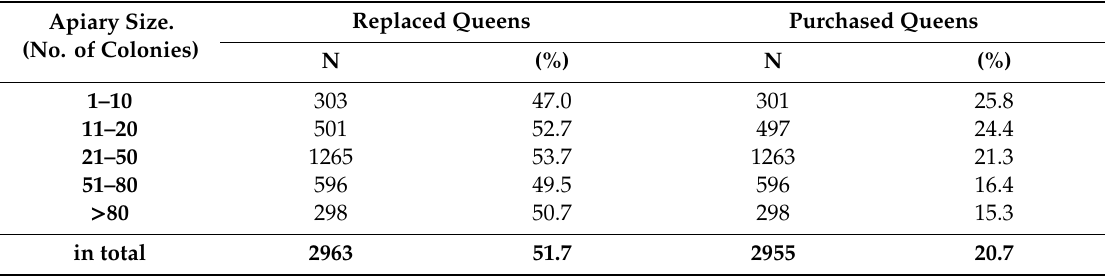
Table A4. Summary numerical characteristics of replaced queens, including purchased ones, analyzed only by apiary size (from 1980 to 2018). Apiary